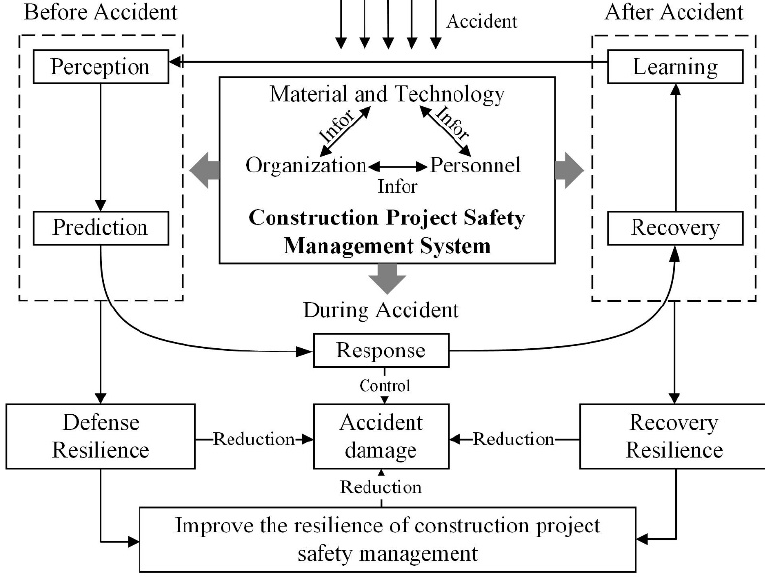
Figure 1. The theoretical framework of construction safety management based on resilience theory.